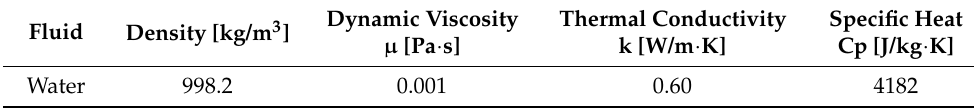
Table 1. The thermo-physical property of water at T = 290 K.